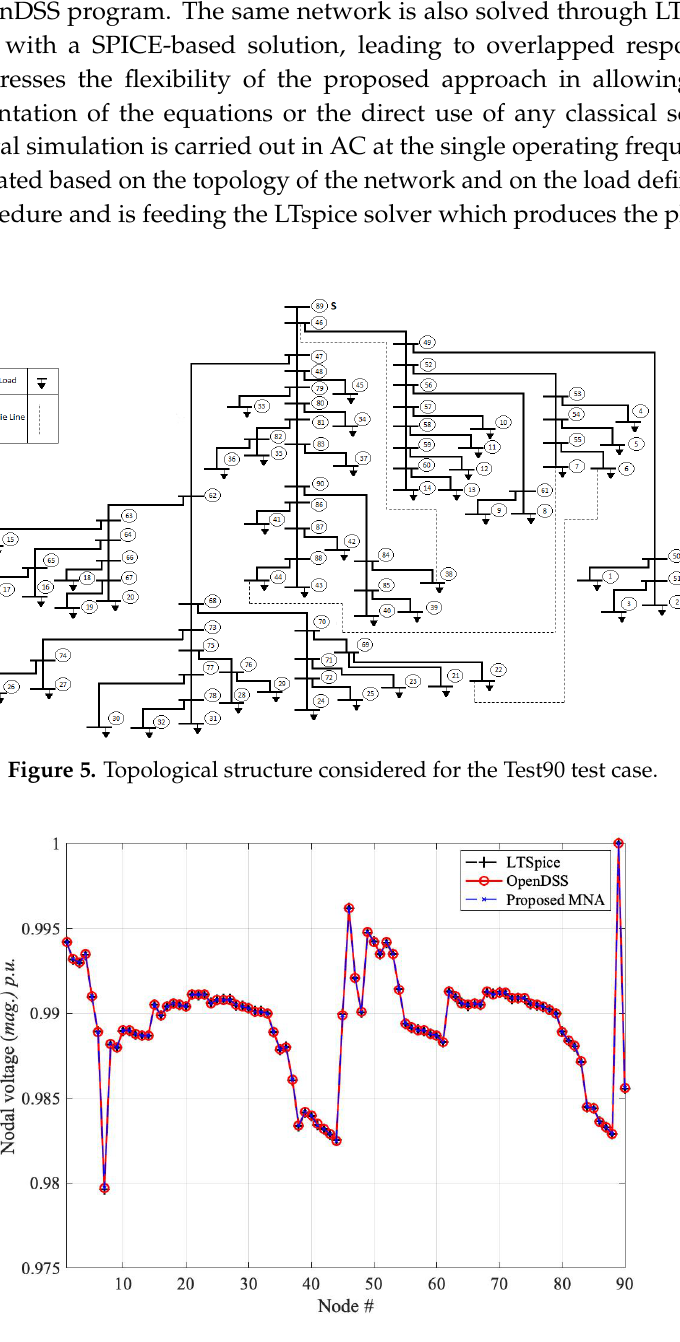
Figure 6. Validation of the Test90 network carried out with the LTspice